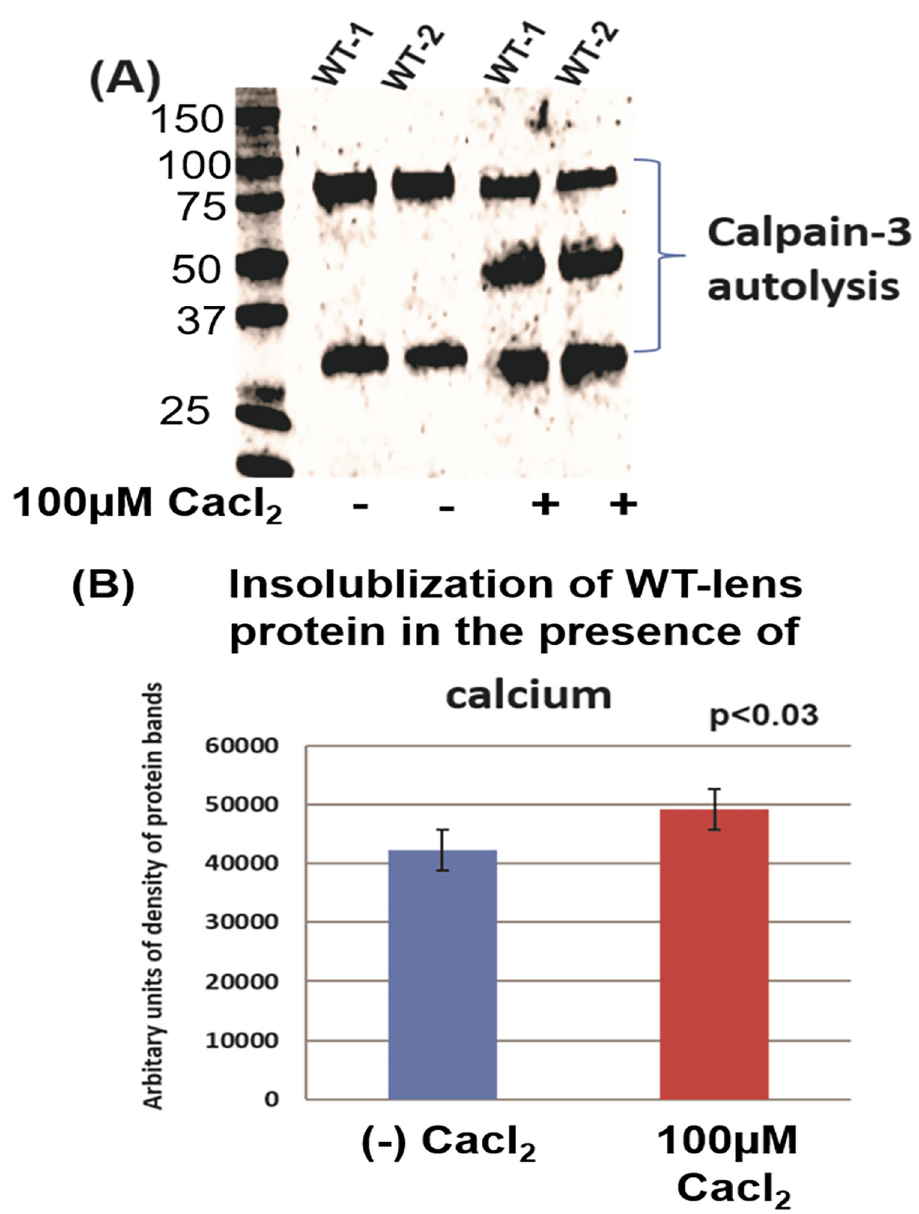
Fig 7. Activation of calpain-3 in homogenate of wild type lenses causes accelerated proteolysis and insolublization of lens proteins. The wild type of lens proteins was homogenized in 10 mM Tris-HCl (pH 7.8) containing 10 mM DTT and 1% SDS and incubated with and without calcium chloride (100 μ M) for 2 h at 37˚C. (A) Calpain-activation (autolysis) was monitored by western blot using anti-calapin-3 antibody. In the presence of 100 μ M calcium, the autolysis of calpain-3 was increased. (B) A greater insolubilization of proteins occurred in the presence of 100 μ M calcium than in absence of Ca +2 . Both Ca +2 -treated and untreated preparations were centrifuged at 5000 rpm and the concentrations of proteins in the soluble- and insoluble-fractions (pellet) were determined by densitometric analysis of proteins after SDS-PAGE. An accelerated autolysis of calpain in Ca +2 -treated preparation was accompanied with a relatively higher amounts of insoluble